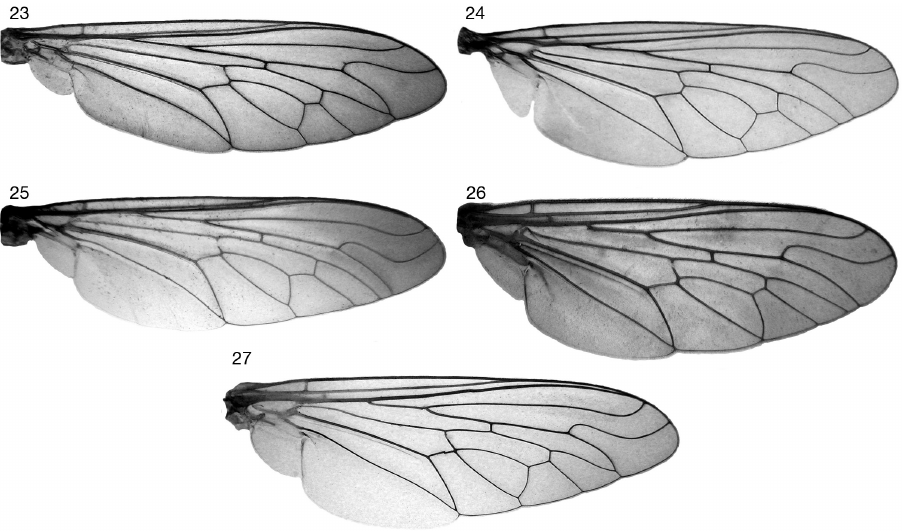
Figures 23–27. Wings of Laphyctis species: 23 L. argenteofasciata (Lokichar ♀ ) 24 L. eremia sp. n. (Gobabeb ♂ ) 25 L. gigantella (NMHUK010624226) 26 L. iota (Kruger Park ♀ ) 27 L. orichalcea (Otjiu ♀ ). Not to same